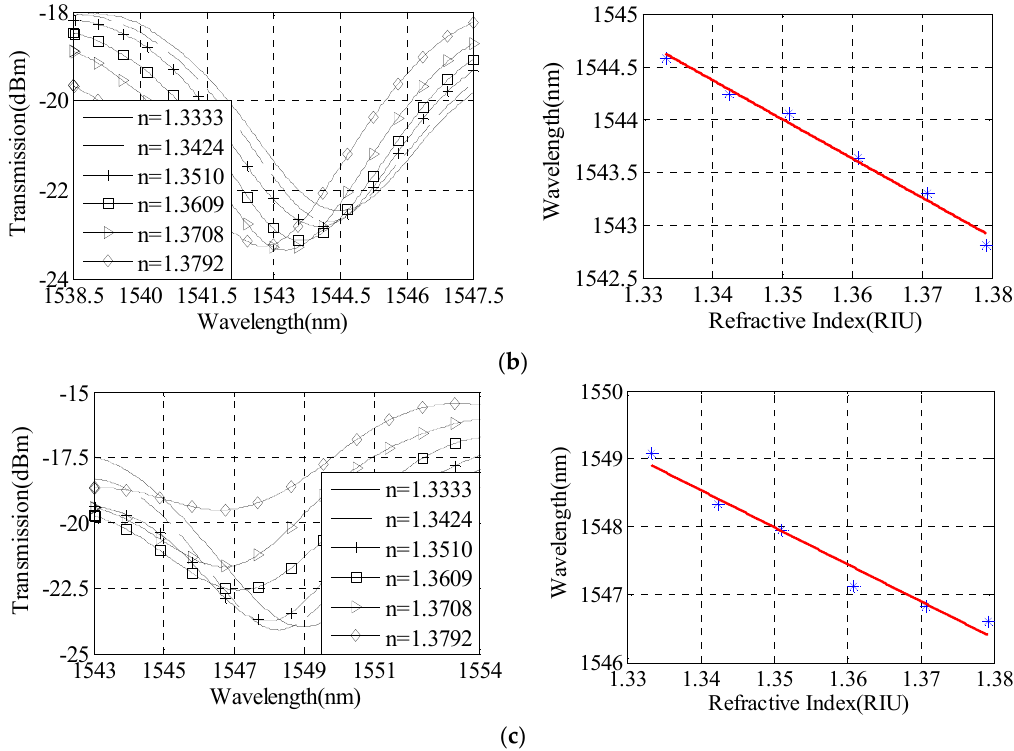
Figure 8. Refractive index measurement sensitivity analysis with different tapers distances. ( a ) L = 4 cm; ( b ) L = 5 cm; ( c ) L = 6 cm.